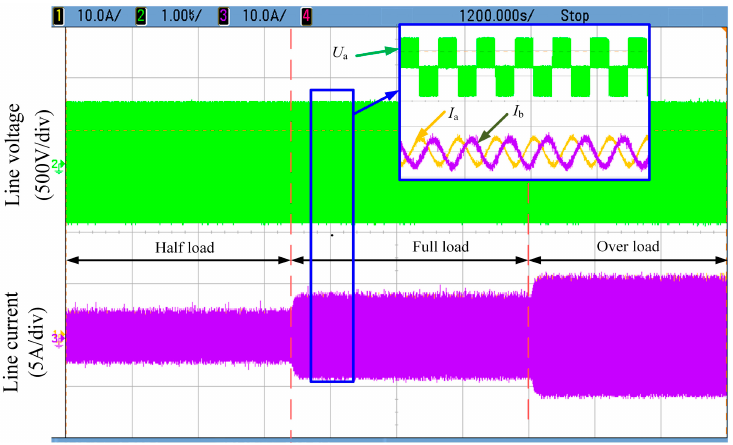
Figure 25. Measured waveforms of CR-PMSM direct-driven turbine system at different load conditions.